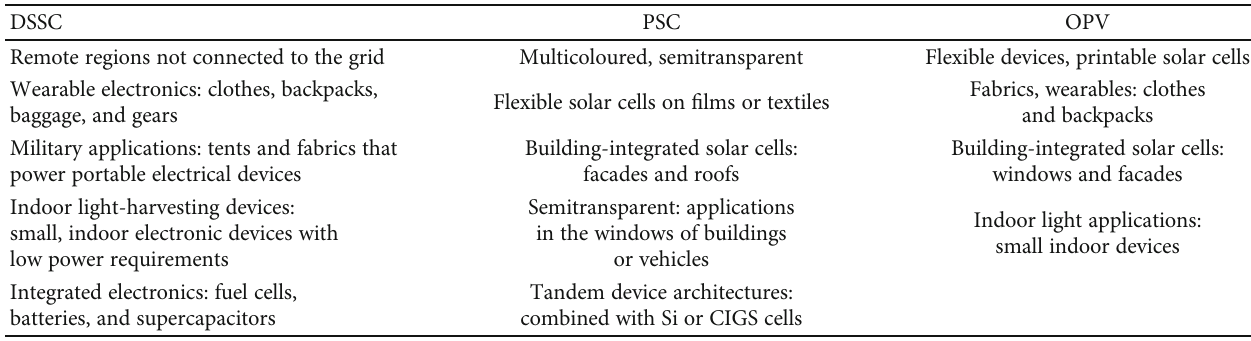
Figure 7: Examples of applications of OPVs: (a) building-integrated photovoltaics, (b) jacket with an incorporated OPV module, (c) backpack, (d) remote control, and (e) solar computer mouse [99]. Table 5: Summary of sustainable energy applications for DSSCs, PSCs, and